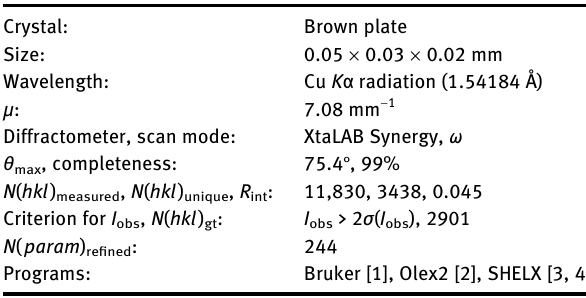
Table  : Data collection and